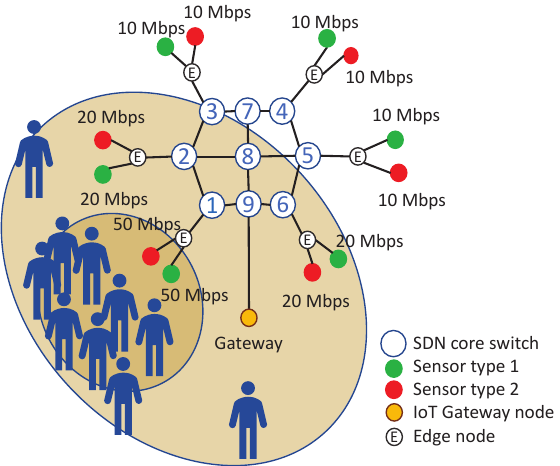
Figure 4. The IoT network topology and the initial traffic rate of sensors when the crowd was close to the edge of core node